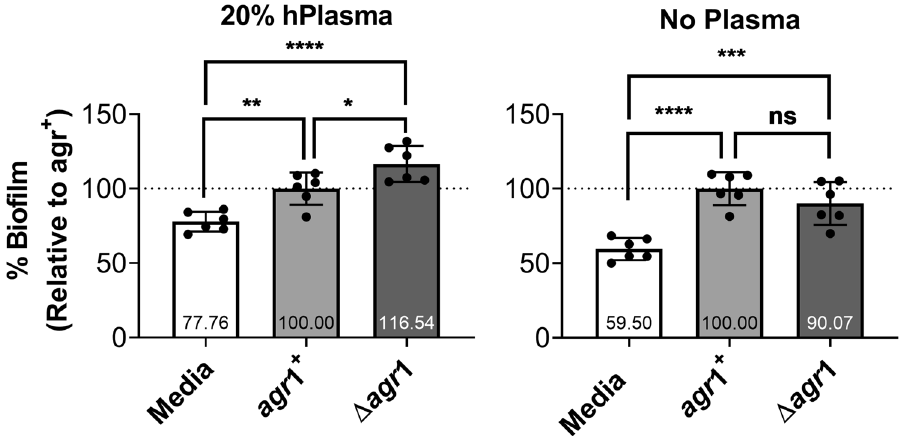
Figure 3. Biofilm enhancement on catheters is also assay dependent. Comparison of biofilm development on 1-cm long segments of BD Vialon catheters with 20% human plasma pre-coating (left) or without plasma pre- coating (right). This is agr 1 strain is AH1263 and its isogenic deletion mutant is AH1292. Data are three catheter replicates repeated twice and are expressed as the mean ± SD (* p < 0.05, ** p < 0.01, *** p < 0.001, **** p < 0.0001, ns = not